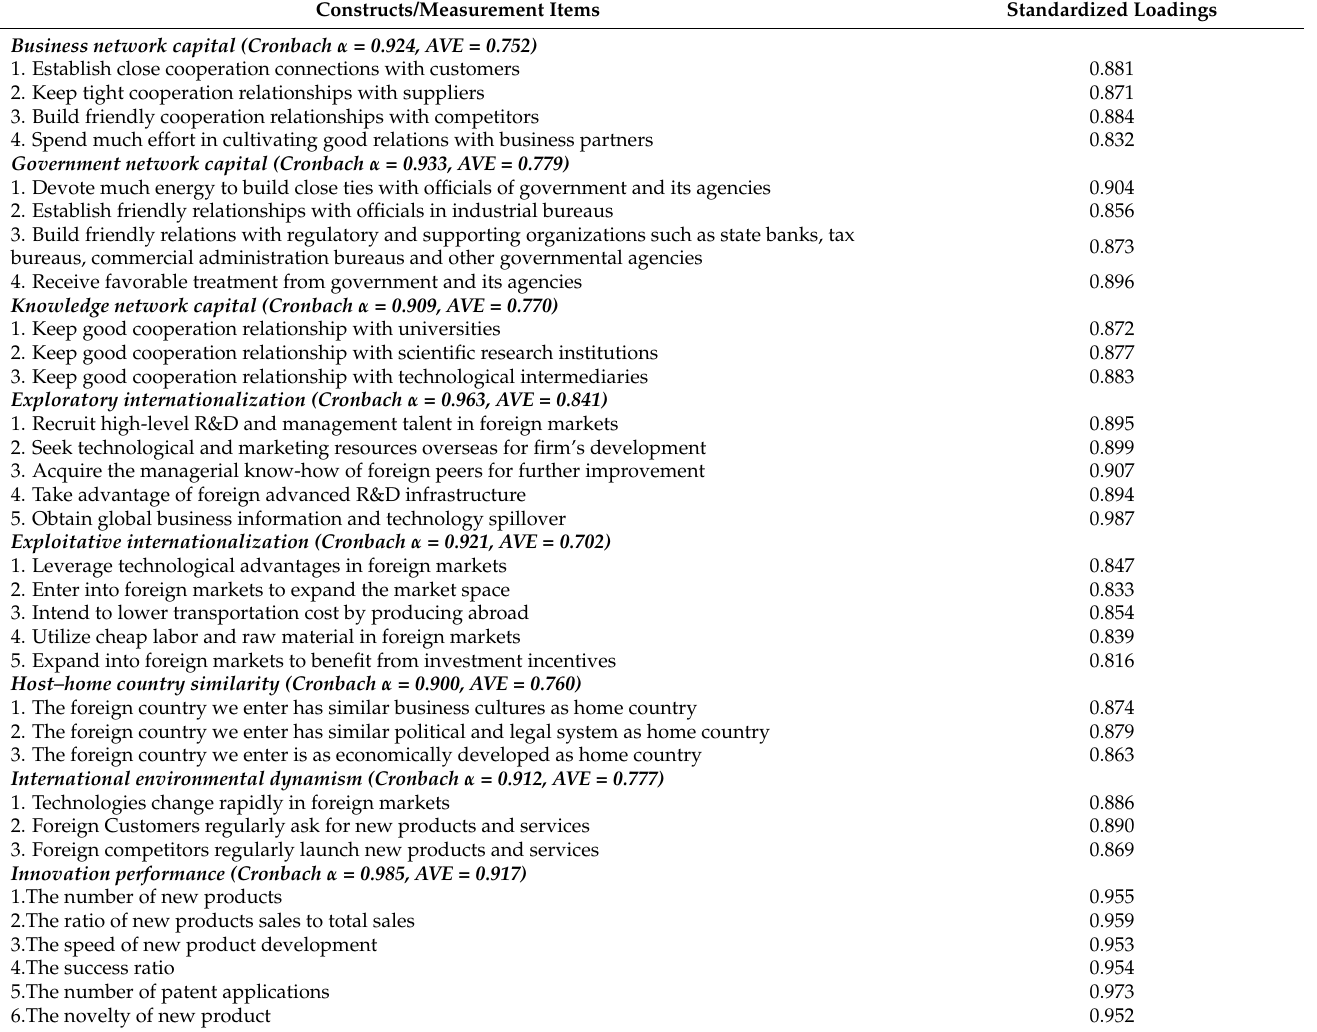
Table 1. To test the discriminant validity, we also calculated the average variance extracted (AVE) for each construct and found that the AVE by the measure of each factor was larger than the squared correlation of that factor’s measure, with all measures of other factors in the model, strongly supporting the discriminant validity. Table 1. Construct measurement and confirmatory factor analysis